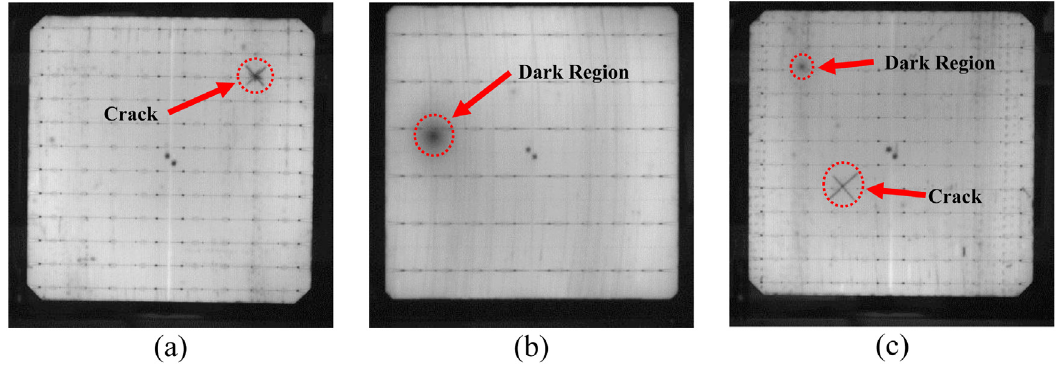
Fig. 2. An example of PL image from each dataset (a) Dataset 1, (b) Dataset 2, and (c)